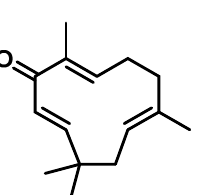
Figure 6. Chemical structure of zerumbone isolated from the fresh rhizome of Zingiber zerumbet